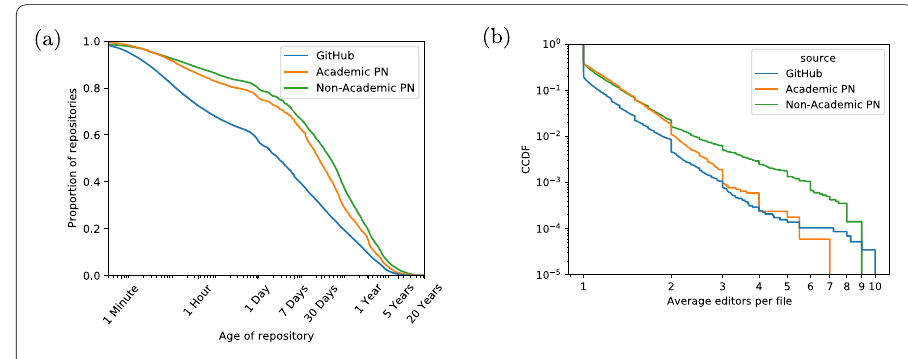
Figure 5 Comparing academic and non-academic Penumbra repositories to GitHub. Fifteen percent of Penumbra hosts are “academic” under our definition, representing 37% of all Penumbra repositories. We find that academic repositories are maintained for about as long as non-academic Penumbra repositories, so academic development practices do not drive the divergence from GitHub development patterns that we observe. Academic repositories have fewer editors per file than non-academic Penumbra repositories, however, more closely matching development practices seen on GitHub. This refutes the hypothesis that the